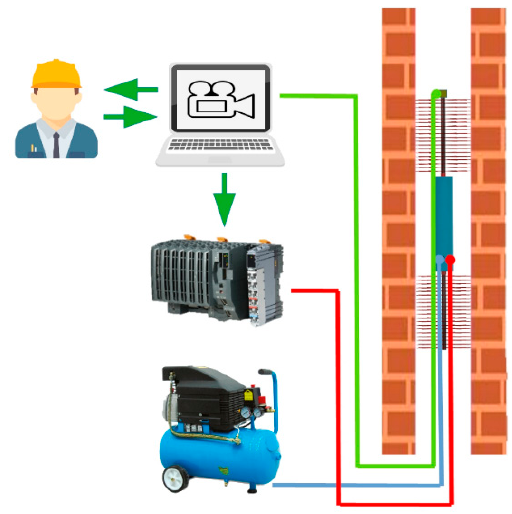
Figure 4. Concept of the chimney robot system .